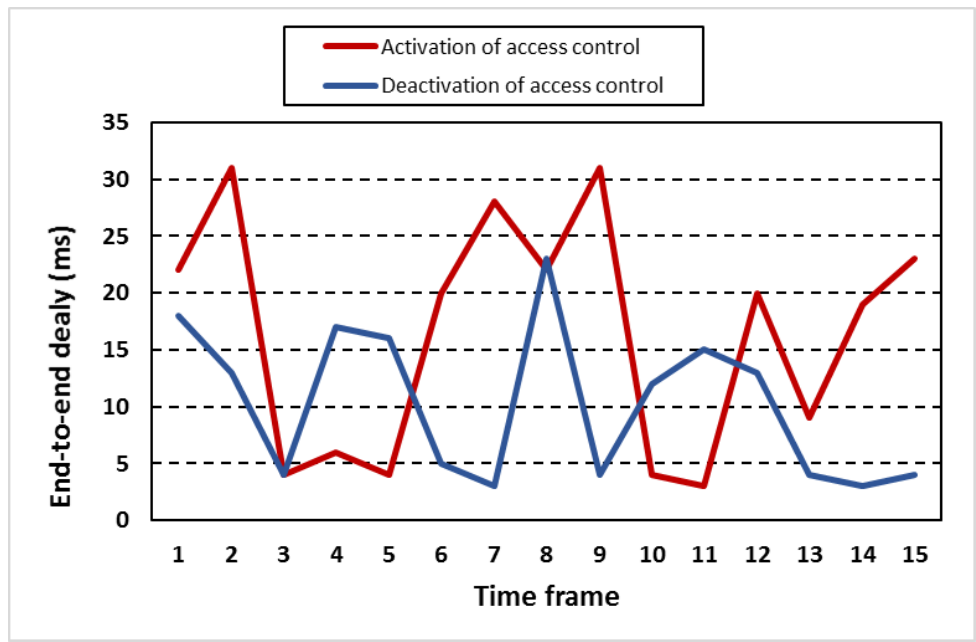
Figure 16. Maximum end-to-end delay between IoT server and web